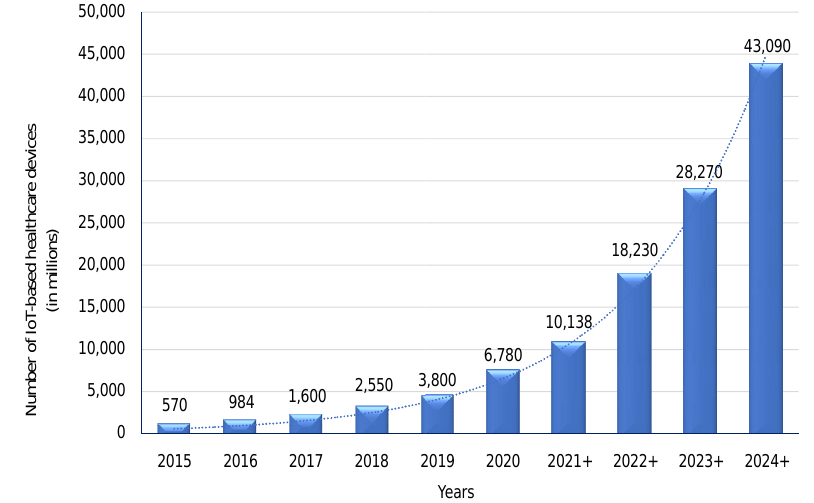
Figure 3. Expected number of IoT-based healthcare